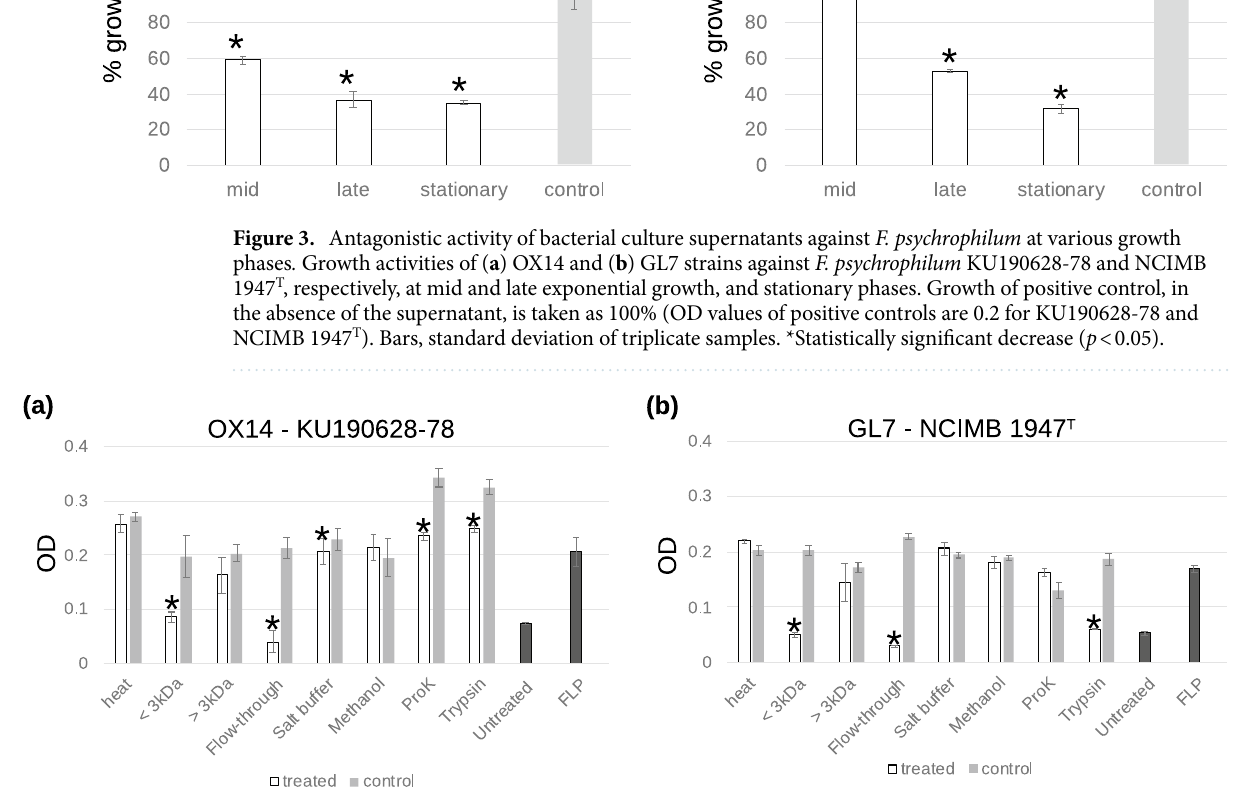
Figure 4. Antagonistic activity of heated, fractionated, and enzymatically digested bacterial culture supernatants against F. psychrophilum . Growth of ( a ) F. psychrophilum KU190628-78 and ( b ) F. psychrophilum NCIMB 1947 T incubated with culture supernatant of strain OX14 and GL7, respectively (white bars). Growth of F. psychrophilum strains with FLP medium similarly treated is used as a positive control (gray bars). Flow- through, flow-through from the anion exchange column. Salt buffer, eluate by high salt buffer. Methanol, eluate by methanol containing 1% formic acid. Growth of F. psychrophilum in untreated culture supernatant is presented as Untreated, and that in FLP medium is presented as FLP. Bars, standard deviation of the triplicates. *Statistically significant